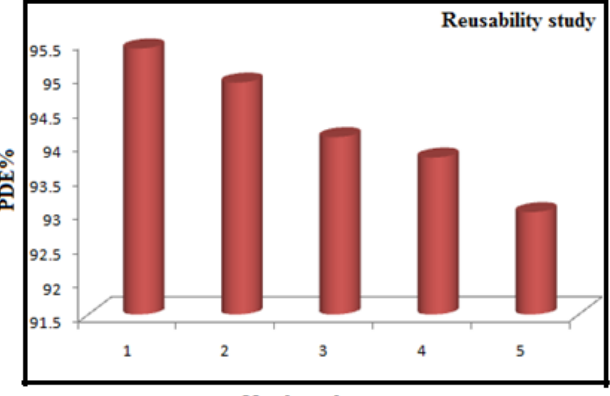
Fig.11. Reuse of catalyst at conditions: dose (2.0) g/100mL, conc.= 30 ppm, initial pH of solution= 5.5 and T= 303K for Methyl orange dye.